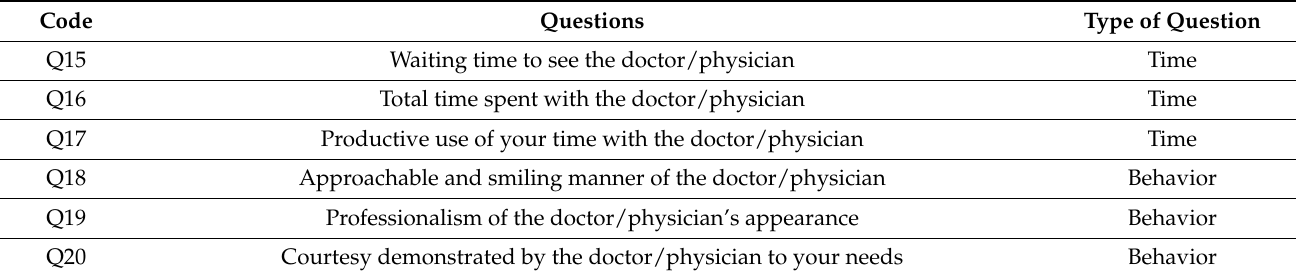
Table 3. Consultation-specific questions in the